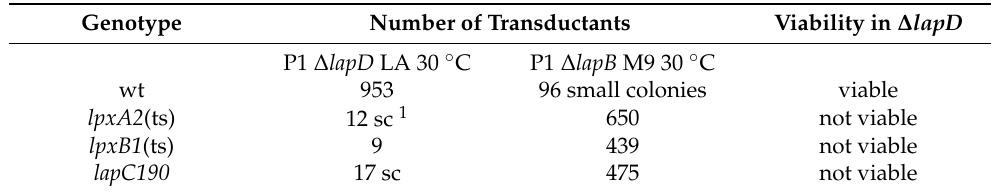
Table 1. A ∆ lapD mutation is lethal when the LPS synthesis is impaired, which is the opposite in the case of ∆ lapB